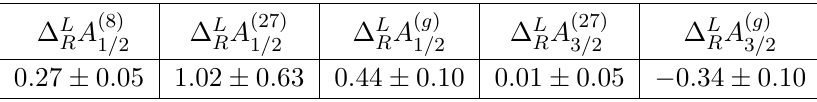
Table 3 . Numerical values for the dispersive loop amplitudes ∆ L